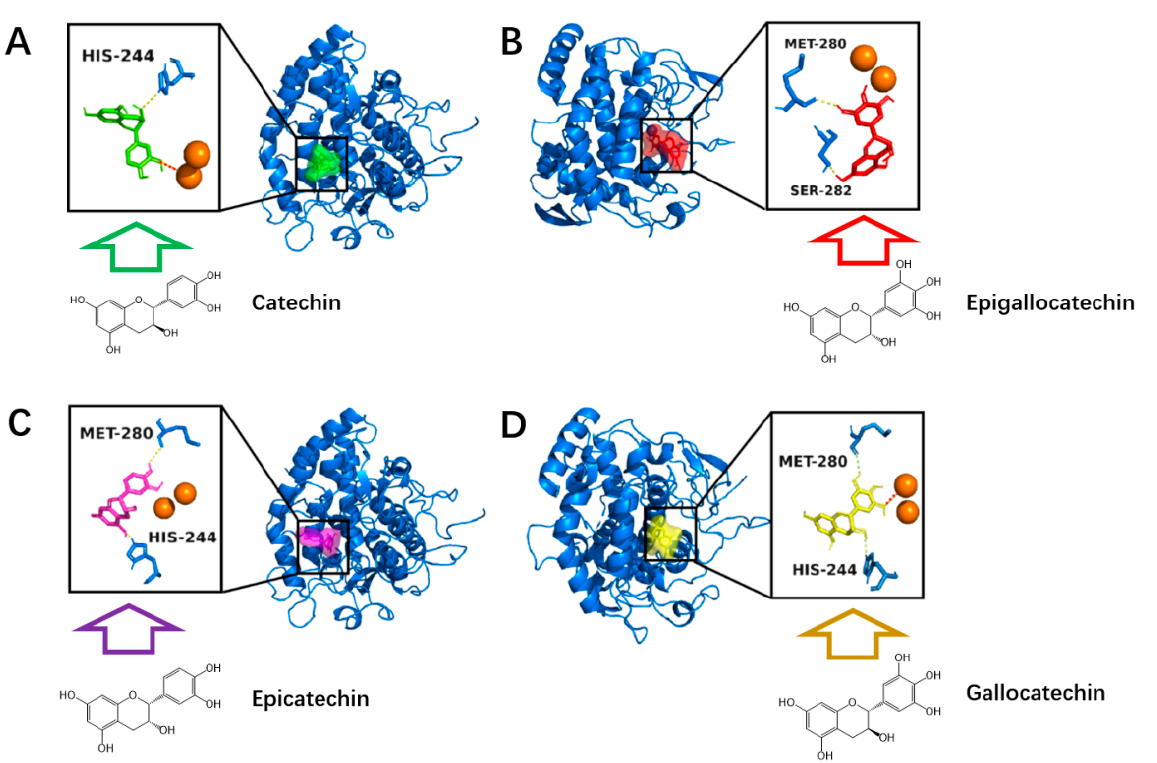
Figure 3. Docking poses of catechin–tyrosinase complex ( A ), epigallocatechin–tyrosinase complex ( B ), epicatechin–tyrosinase complex ( C ), and gallocatechin–tyrosinase complex ( D ). The dotted lines were hydrogen bond formed between tannin and tyrosinase.